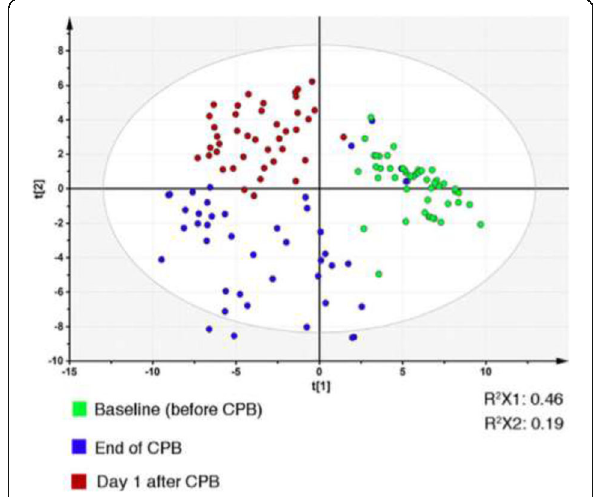
Table 1 (abstract 0165). Demographic personal characteristics of the patients